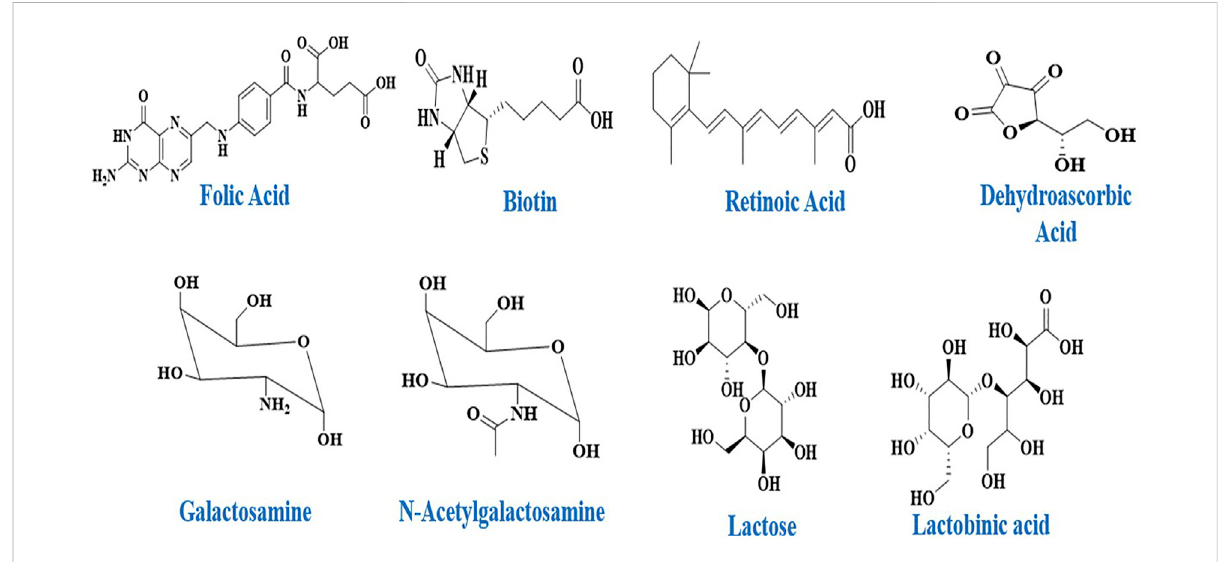
FIGURE 2 Some example of Targeting Ligands utilized in SDDSs.